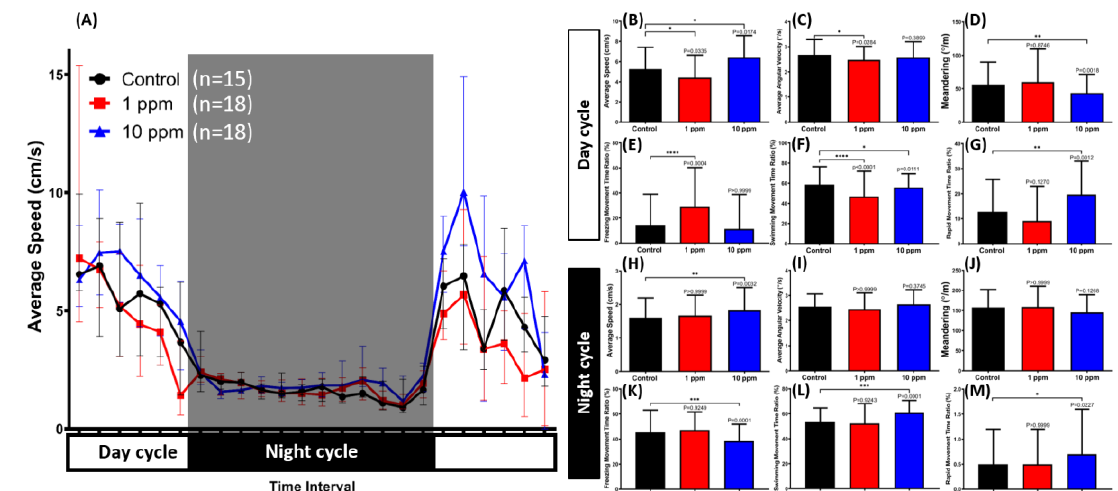
Figure 7. The circadian rhythm assay for Fe 3 O 4 MNPs-exposed zebrafish after 14-day exposure. ( A ) Comparison of chronological changes of the average speed in light and dark cycles. The grey area shows the dark period while the white area shows the light period. Comparison of the ( B ) average speed, ( C ) average angular velocity, ( D ) meandering, ( E ) freezing movement time ratio, ( F ) swimming movement time ratio, and ( G ) rapid movement time ratio at the light cycle. Comparison of the ( H ) average speed, ( I ) average angular velocity, ( J ) meandering, ( K ) freezing movement time ratio, ( L ) swimming movement time ratio, and ( M ) rapid movement time ratio during the dark cycle. The data are expressed as the median with an interquartile range and were analyzed by a Kruskal-Wallis test, which continued with Dunn’s multiple comparisons test as a follow-up test ( n = 15 for control, n = 18 for 1 and 10 ppm MNPs-exposed group, * p < 0.05, ** p < 0.01, *** p < 0.001, **** p < 0.0001).